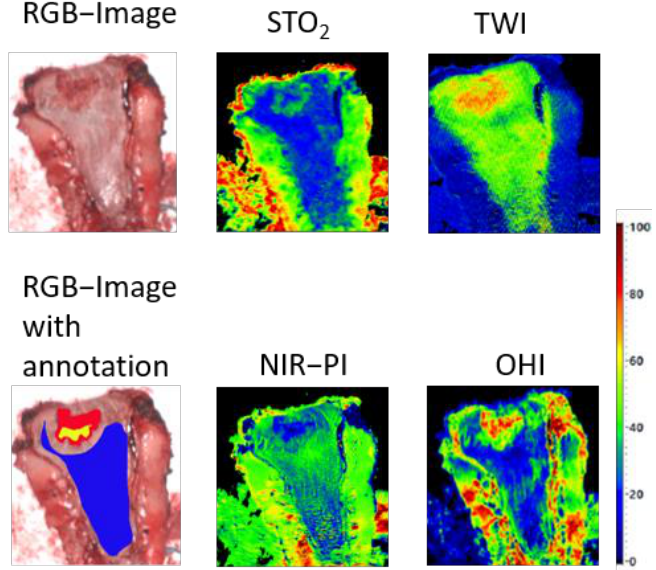
Figure 5. An example of tissue specimen with a tumor (ypT2). Tissue structures show homogeneous physiological parameter values (blue: healthy mucosa, yellow: cancer, red: tumor margin). Near-infrared (NIR) fluorescence imaging with indocyanine green (ICG) can also be